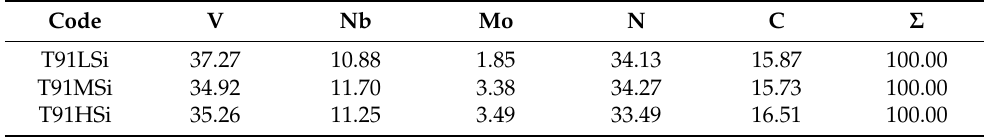
Table 4. Amount proportion in MX phase (at.%).